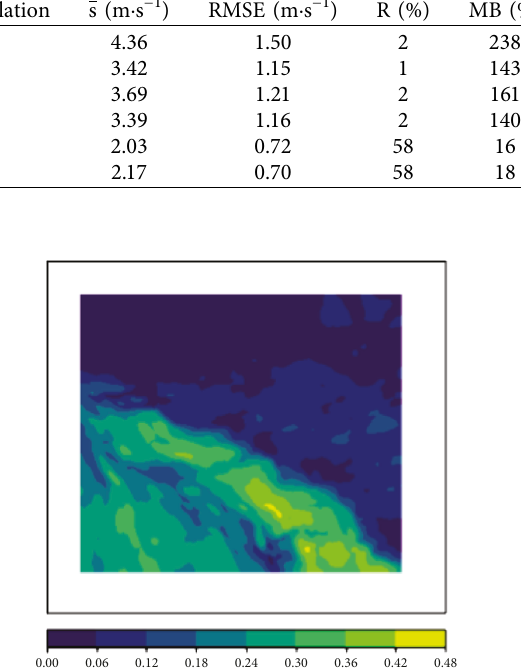
Figure 4: Difference between potential temperature over D2 at 20.0 and 2.5m.